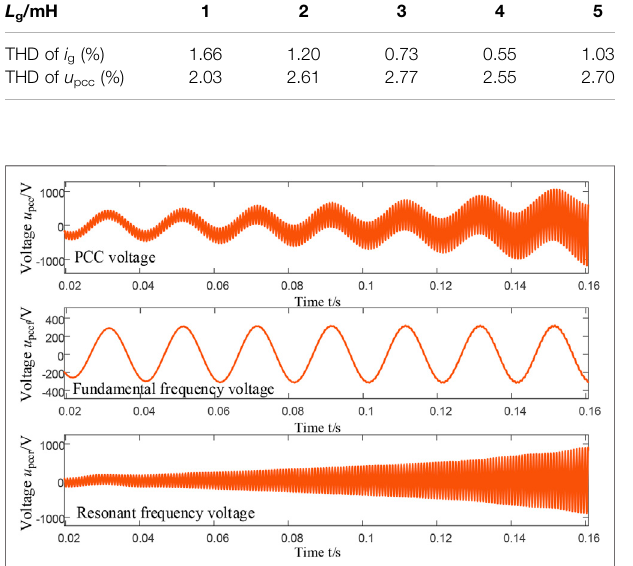
FIGURE 15 | Voltage signal detection waveform under resonance.